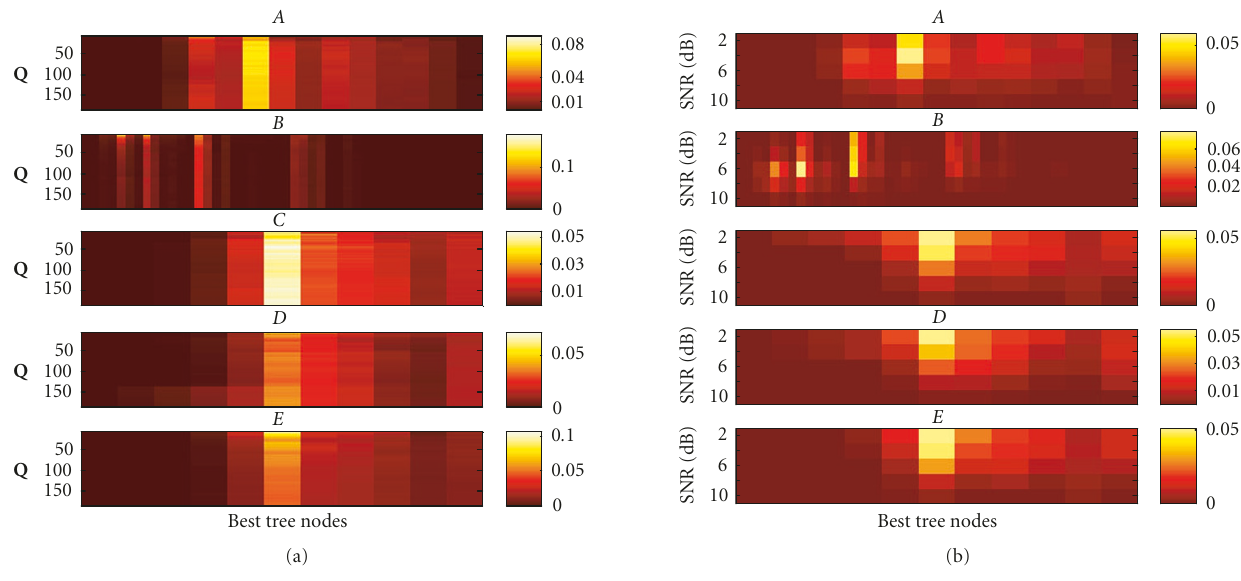
Figure 13: (a) Variance of λ l 1 , l ∈ J p ( p = { A , B , C , D , E } ), versus sample size Q (SNR = 4 dB) (b) Variance of λ l 1 , l ∈ J p , versus SNR. (Nodes with zero eigenvalues are suppressed for clarity.)